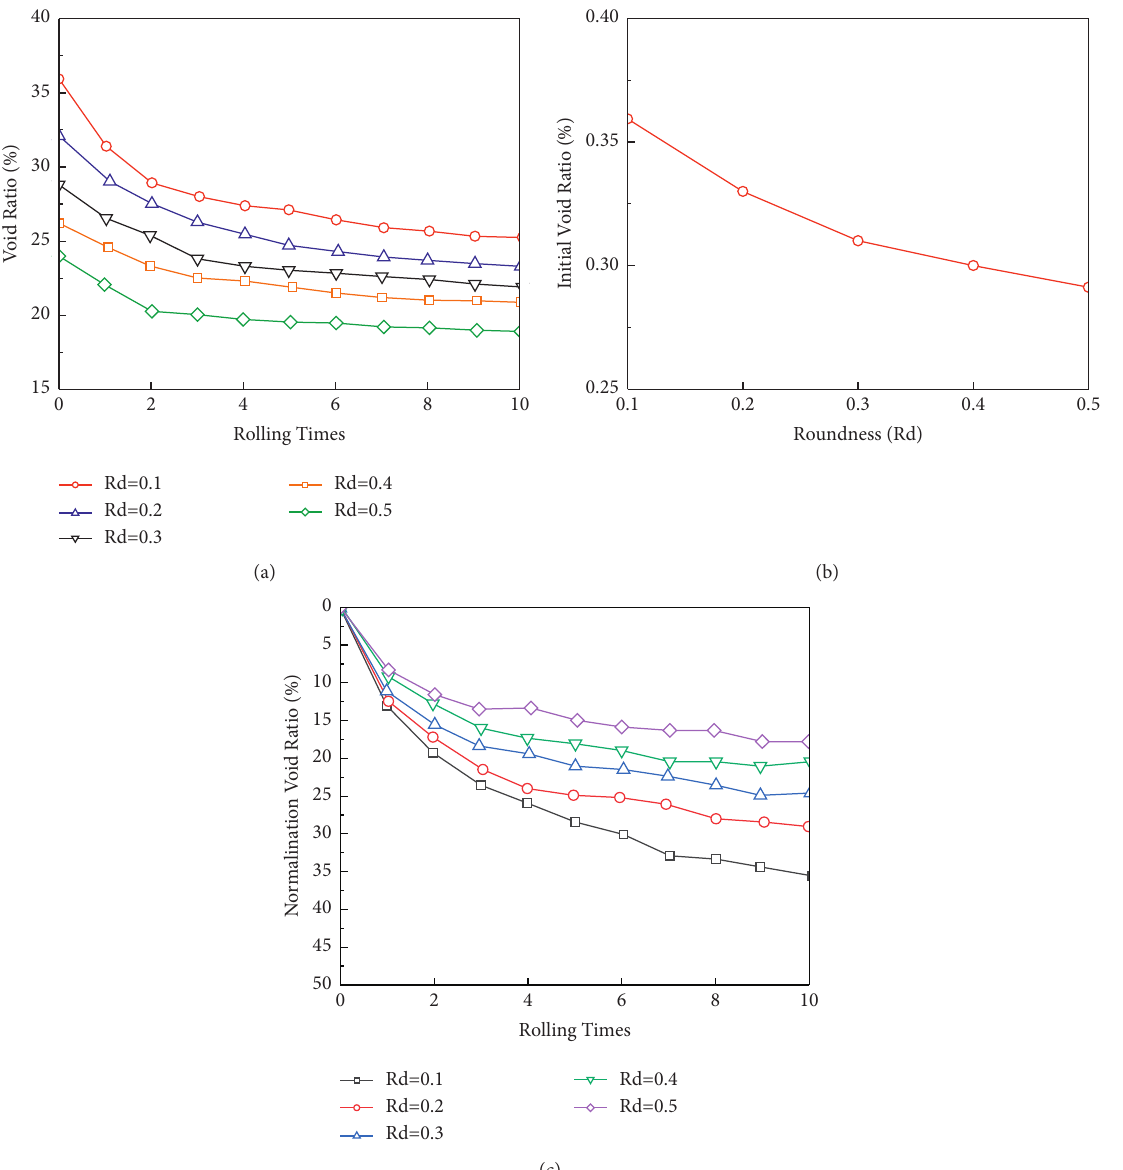
Figure 16: The relationship between the compactor pass and pore change of fillings with different roundnesses. (a) Porosity; (b) initial porosity; (c) normalized void change